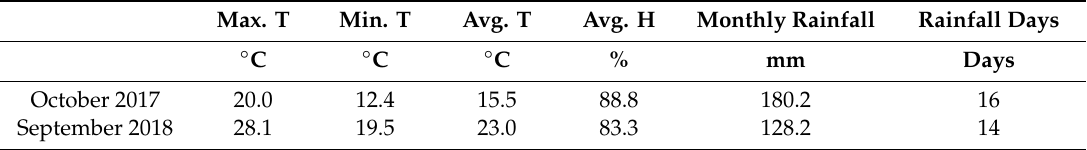
Table 2. Temperature, humidity, and rainfall in Huoshan, the UPRB [29]. Max. T Min. T Avg. T Avg. H